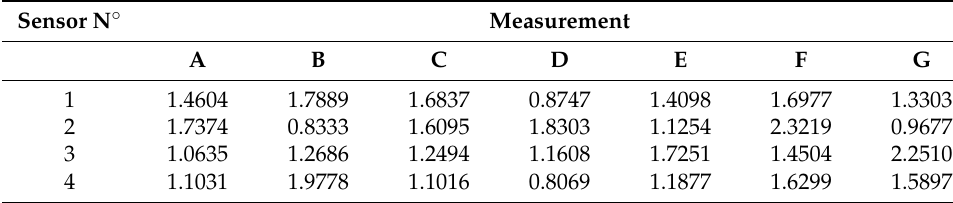
Table 8. Integral of frequency spectrum (10 − 1 ), slab with no void.